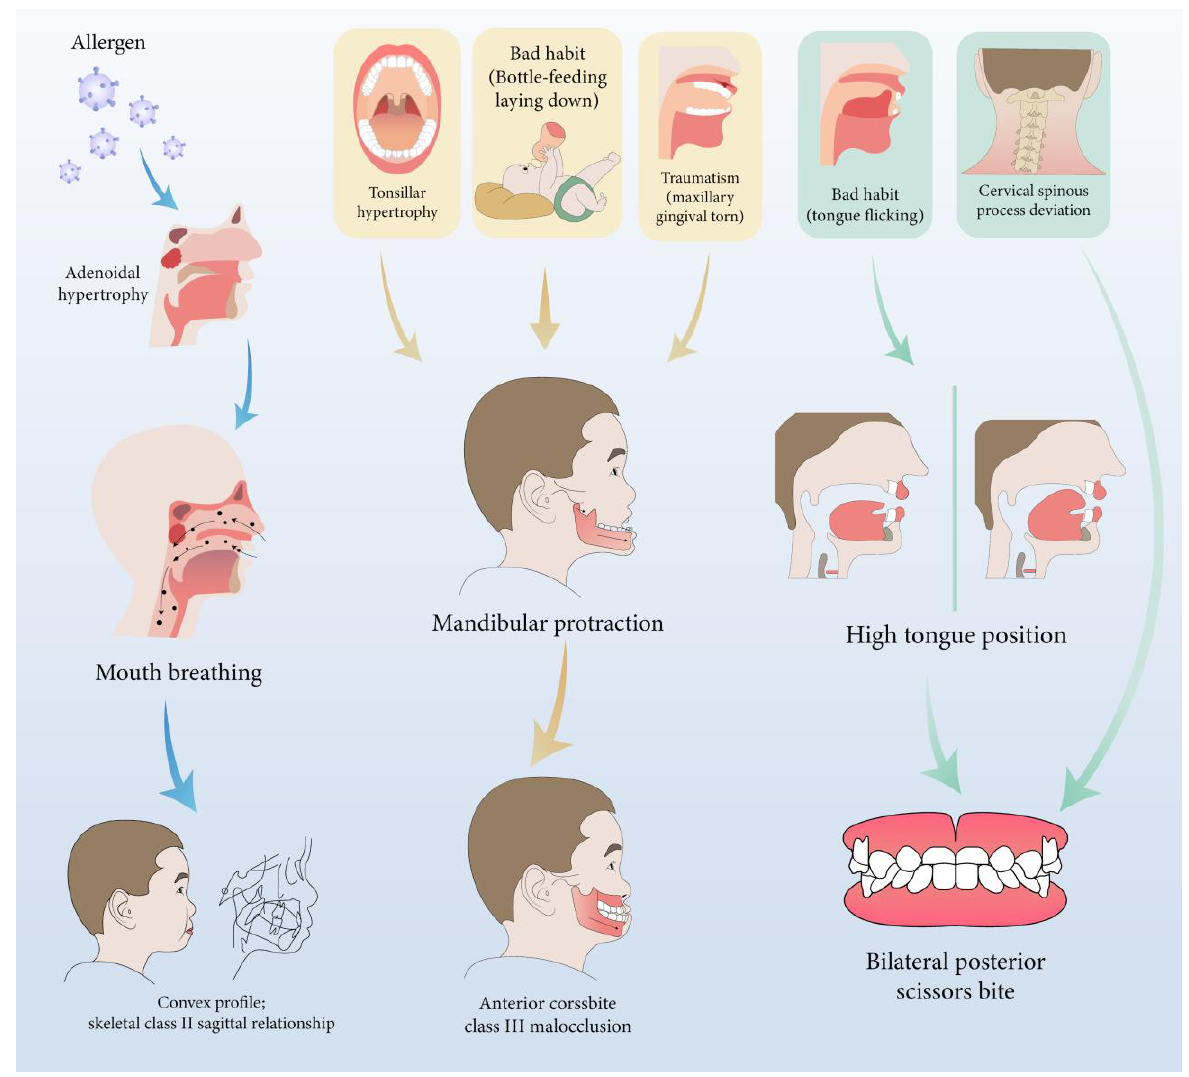
Figure 20. The inference diagram of the relationship between etiology, mechanism and clinical man- ifestations.